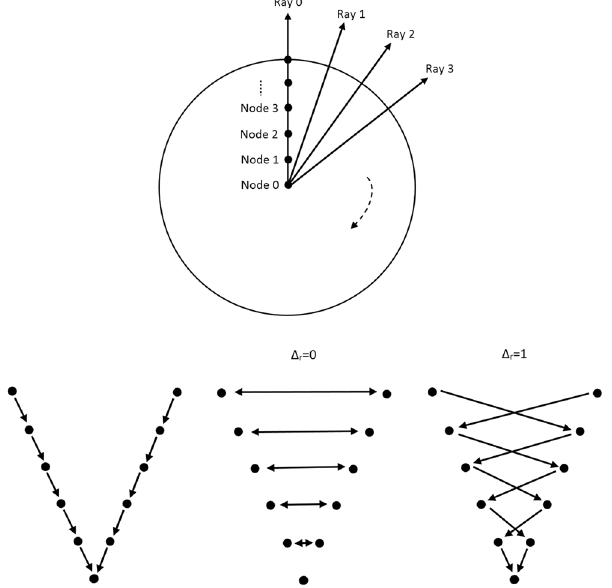
Figure 4. Underlying principle of the graph construction for the interactive segmentation: The upper image shows how the nodes for the graph are sampled. Rays are distributed radially clockwise around a fixed point. Along these rays, the nodes (0, 1, … ) are sampled. Bottom images: The intra-edges are constructed within the single rays (an example for two rays is shown in the leftmost image). The next step is to construct the inter- edges between the rays under the specification of the delta value Δ r : for a delta value Δ r of zero ( Δ r = 0), only inter-edges are allowed that connect nodes on the same “level” along the rays (see image in the middle). For a delta value Δ r of one ( Δ r = 1), inter-edges are allowed that connect nodes on different “levels” along the rays, however, only with a maximum “level” distance of one (see rightmost image). Note: the delta values can also be higher, e.g., 2, 3 and so on. Note: figure adapted from 26